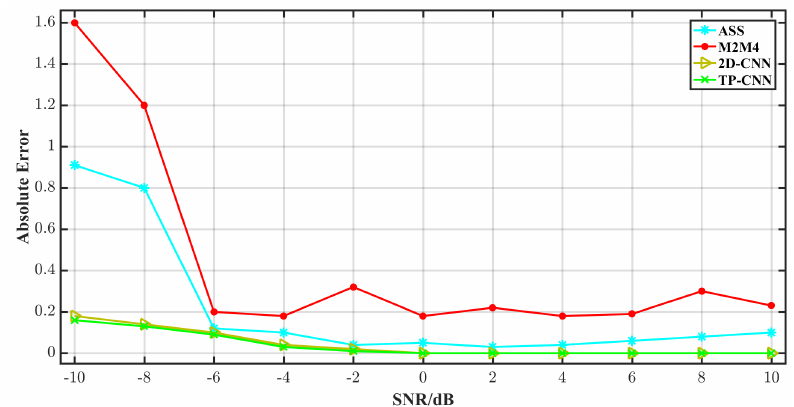
Figure 9. Relative error of four algorithms evaluated at different SNRs.